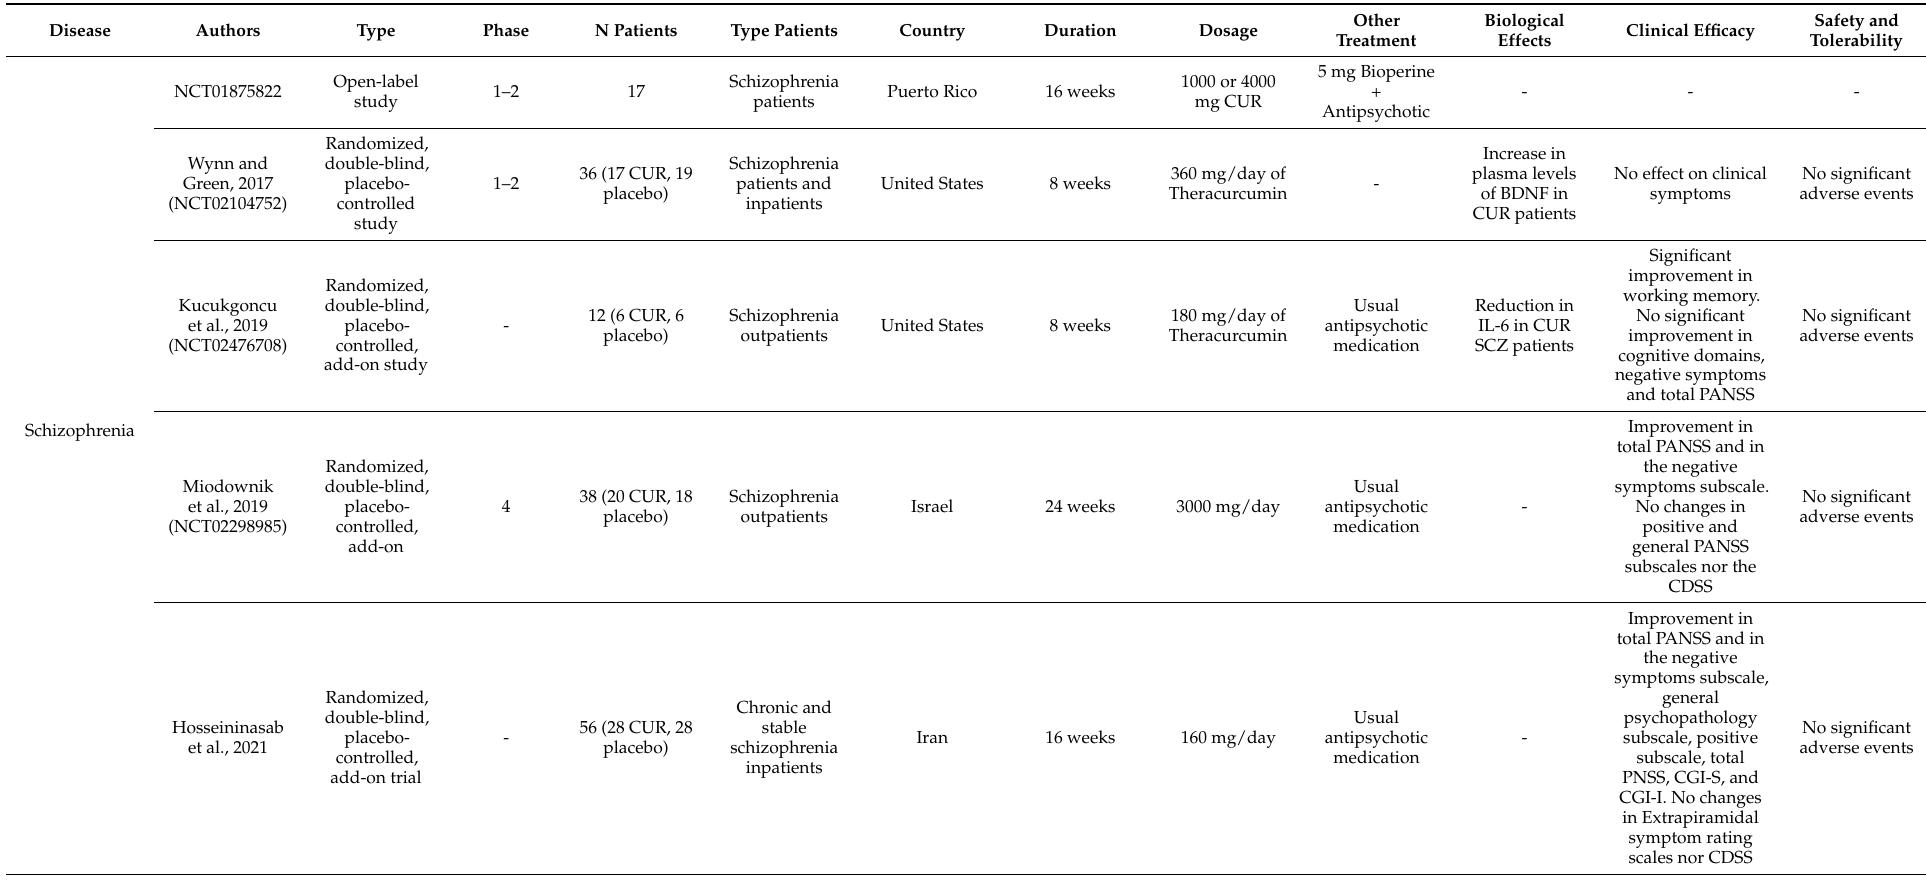
Table 1. Clinical studies and trials in neuropsychiatric